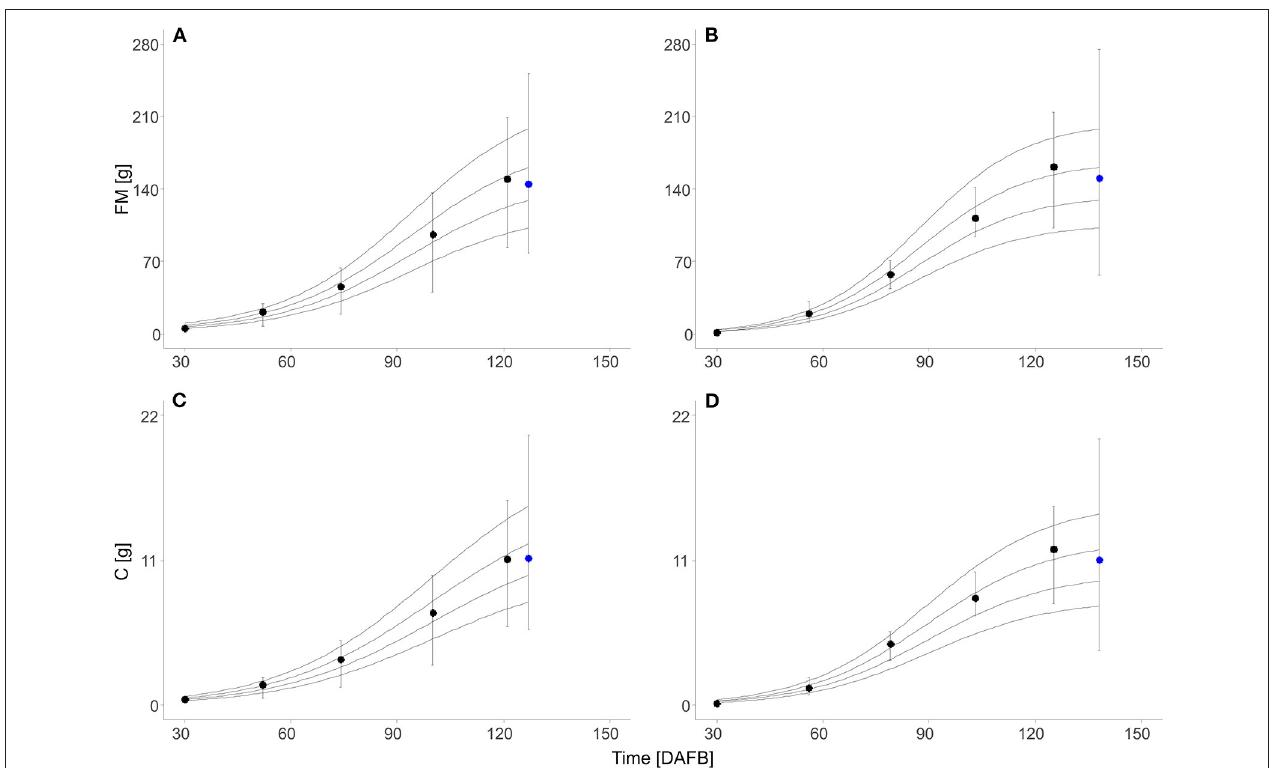
FIGURE 1 | Fresh mass (FM) (A,B) and absolute C content (C fruit ) (C,D) of ‘Gala’/M.9 apples during the season (black circle, n = 30) and at harvest (blue circle, 2018: n = 180; 2019: n = 1,240) in days after full bloom (DAFB) in 2018 (A,C) and 2019 (B,D) . Symbols represent the measured means, error bars show the SD , and solid lines show the sigmoid-growth functions simulated for the fruit with 65, 70, 75, and 80mm diameter at harvest (from the bottom to top).